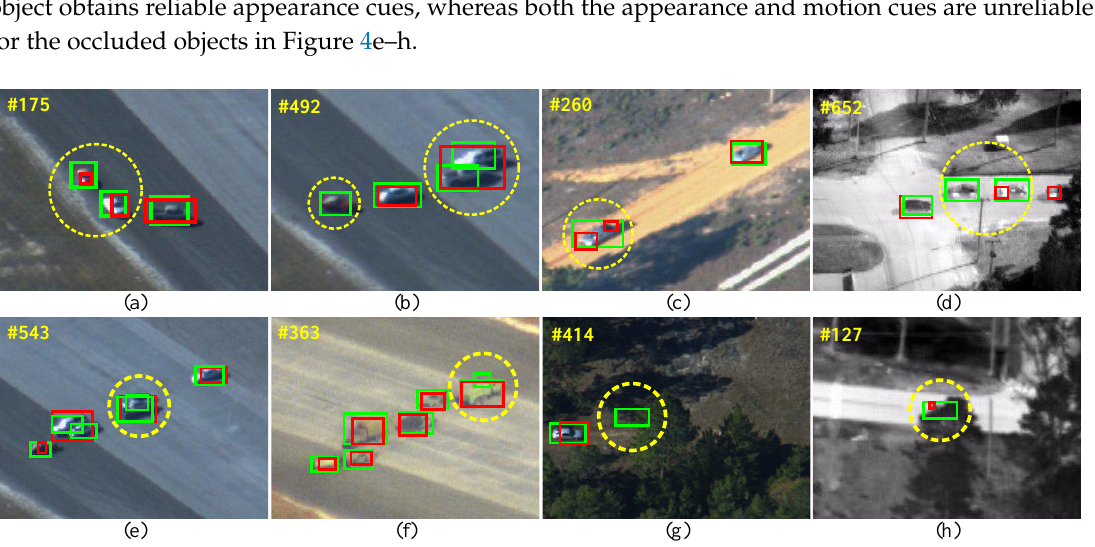
Figure 4. Illustration of Stage 1 association. The bounding boxes with the red color are the detection results. The bounding boxes with the green color are appearance-based predictions as a result of the Fast Compressive Tracker (FCT). The unmatched objects are marked with a yellow dotted circle and yellow color. ( a – d ) Matched objects having a high tracklet confidence; ( e – h ) matched objects having a low tracklet